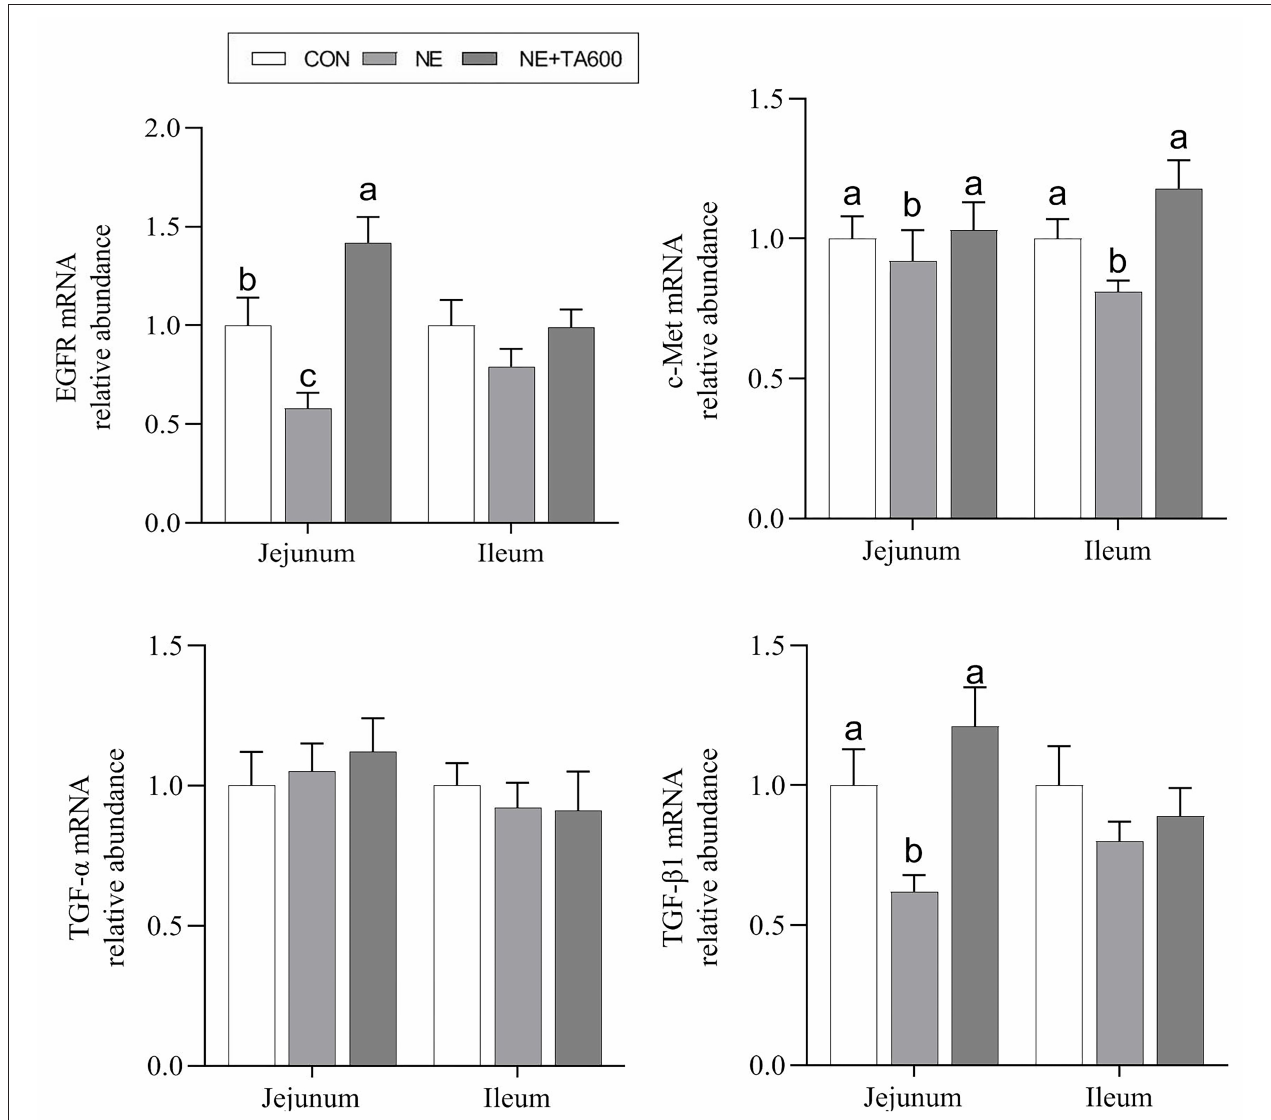
FIGURE 5 | Effects of TA on the mRNA abundance of intestinal mucosal repair factor of subclinical NE broilers. Values are means with their standard errors represented by vertical bars. a − c Means within a row with different letters differ significantly ( p < 0.05). EGFR, epidermal growth factor receptor; c-Met, c-mesenchymal epithelial transition factor; TGF- α , transforming growth factor-alpha; TGF- β 1, transforming growth factor-beta